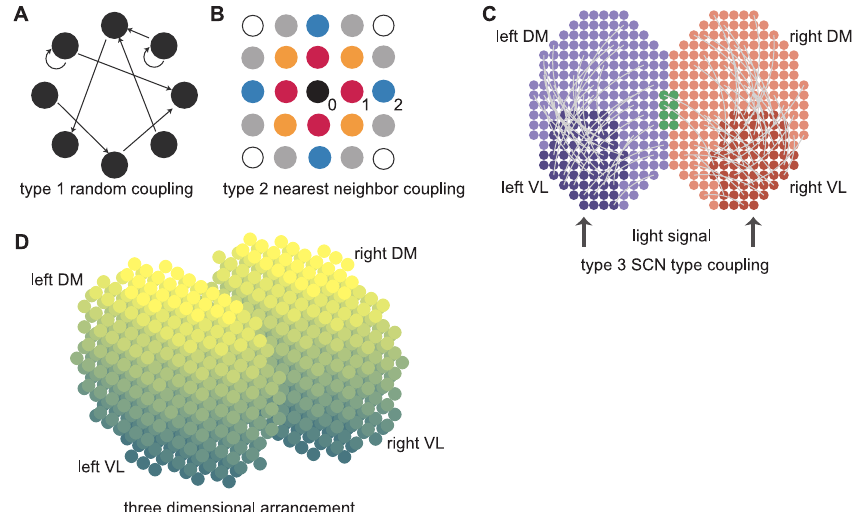
Figure 2. Organization of the Circadian Oscillator Networks (A) Random coupling (type 1). The probability that two oscillators are connected is independent of their positions. (B) Nearest-neighbor coupling (type 2). Oscillators are on a grid with a Euclidian distance d . Circle representing oscillators are color-coded for their distance from the central black oscillator. Black, red, orange, blue, gray, and white circles are at distances d ¼ 0, 1, ffiffiffi 2 oscillators are connected if their distance is less than a threshold d max . (C) SCN-like coupling (type 3). The SCN is divided in four regions, left and right VL regions (dark blue and red, respectively), and left and right DM regions (light blue and red, respectively; the green part is the intersection between left and right DM regions). Each dot represents an oscillator. Projections from the VL regions to their respective DM regions are indicated by light gray arcs. Projections from one cell to another are assigned randomly, with probability 0.5 for a DM cell to receive a projection. (D) Representation of a 3-D SCN. Each dot is a cell, and the color gradient indicates the VL–DM axis (dark cells are on the VL side and light cells are on the DM side, corresponding to the vertical axis in [C]). For type 3 coupling in a 3-D SCN, the regions are defined in the same way as in 2-D (C).